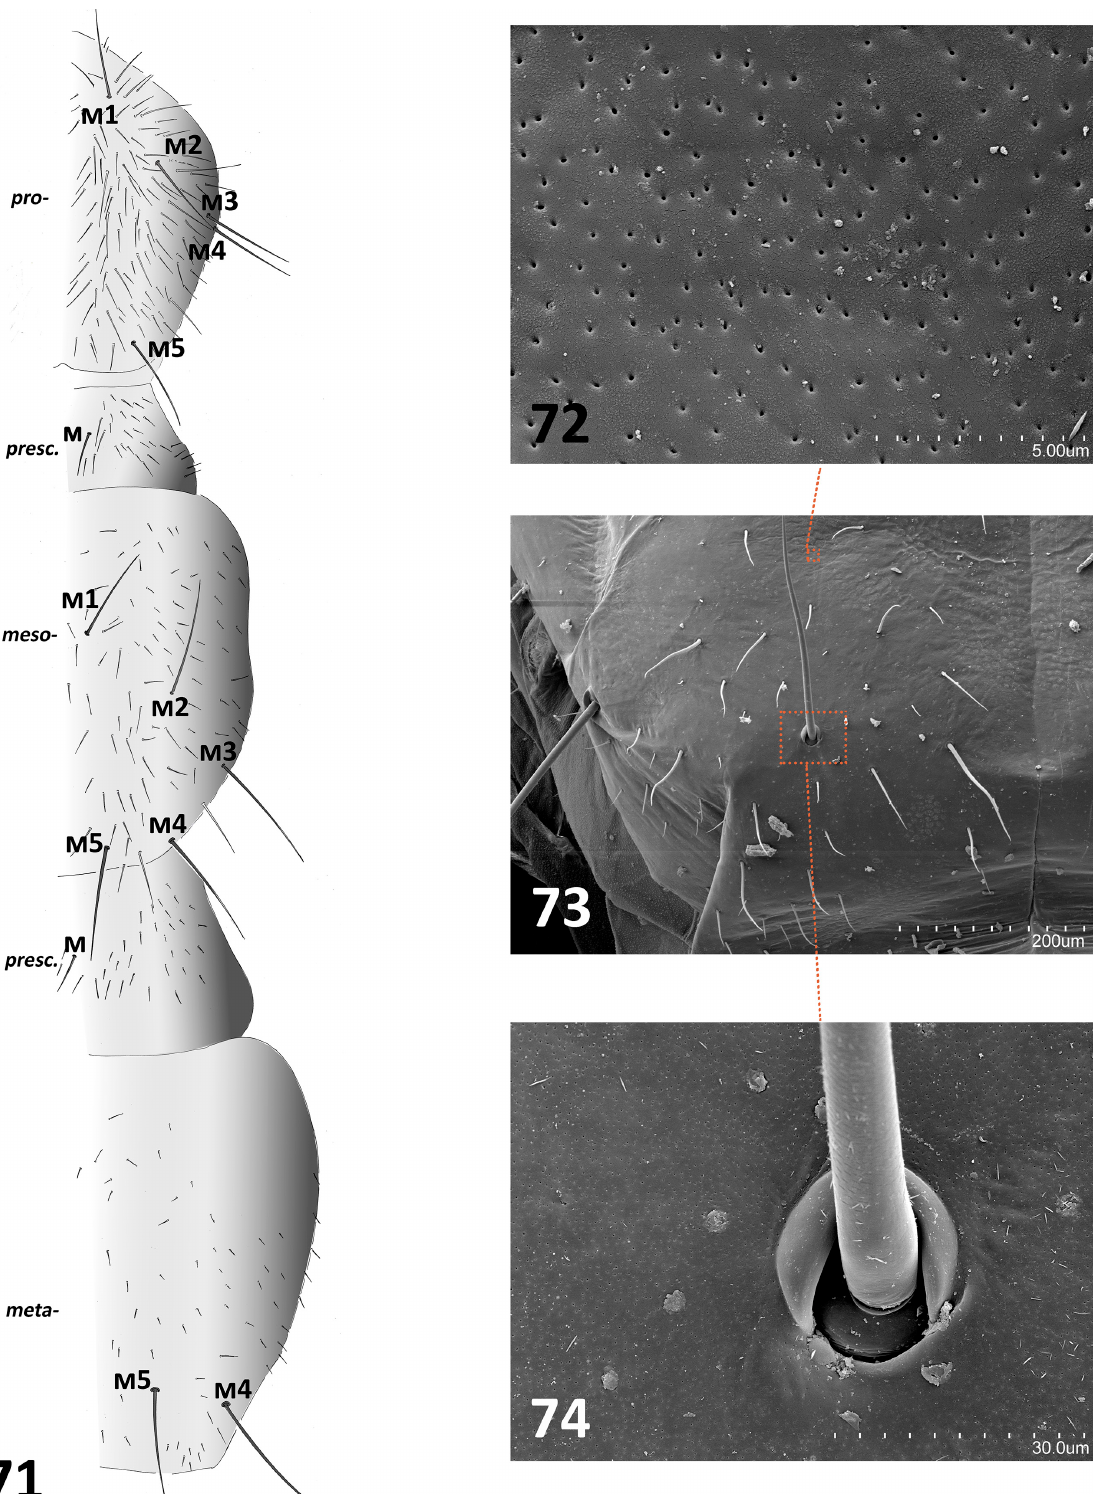
Figs 71‒74. Mueggejapyx brehieri Sendra & Komerički gen. et sp. nov. 71 . Pronotum, mesonotum and metanotum, right side, see terminology in the text (holotype, MZB (MCNB) 2020-1156). 72 . Detail of the surface of the mesonotum. 73 . Detail of the latero‒posterior left side of the mesonotum. 74 . Detail of the macroseta